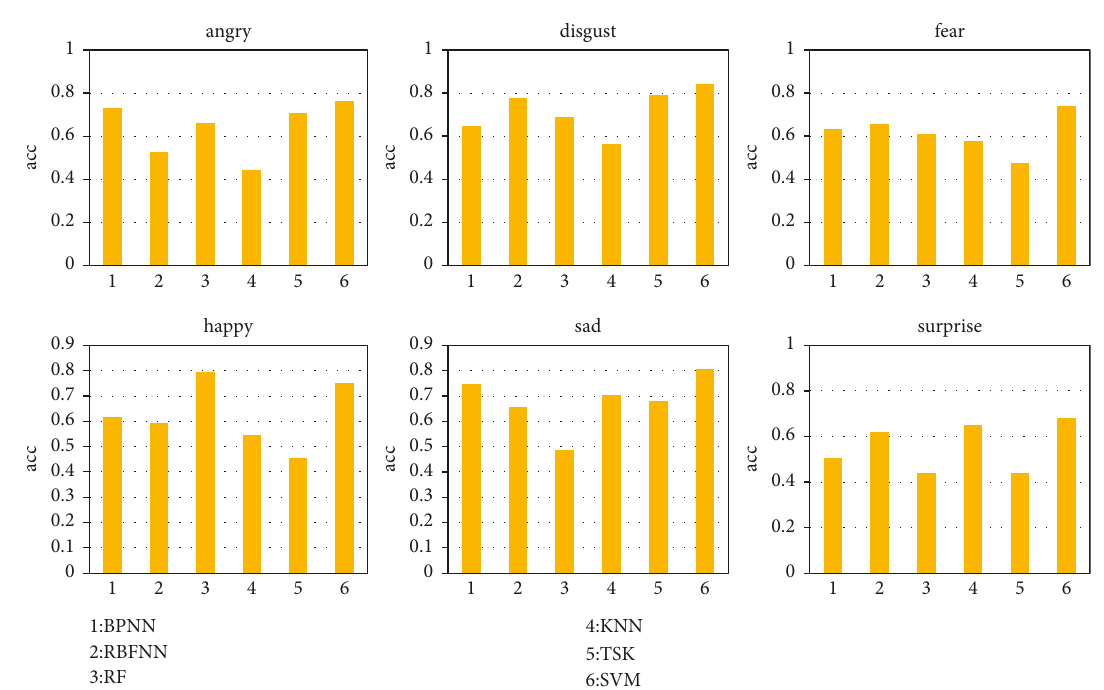
Figure 4: Comparison of emotion recognition results based on body